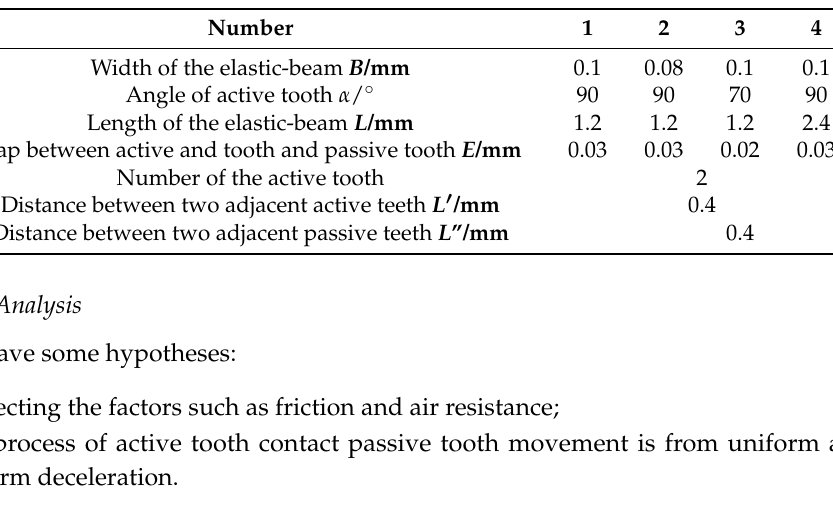
Table 1. The parameters of elastic-beam delaying